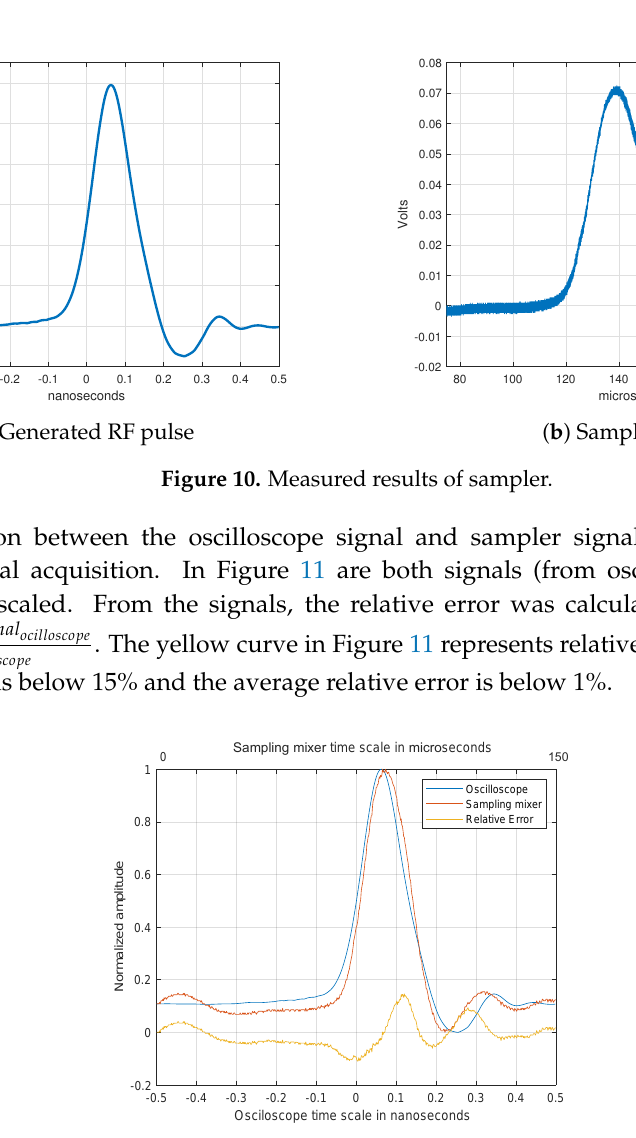
Figure 9. Prototype of radar without antennas ready for test measurements. Instead of an antenna, the attenuator is connected.